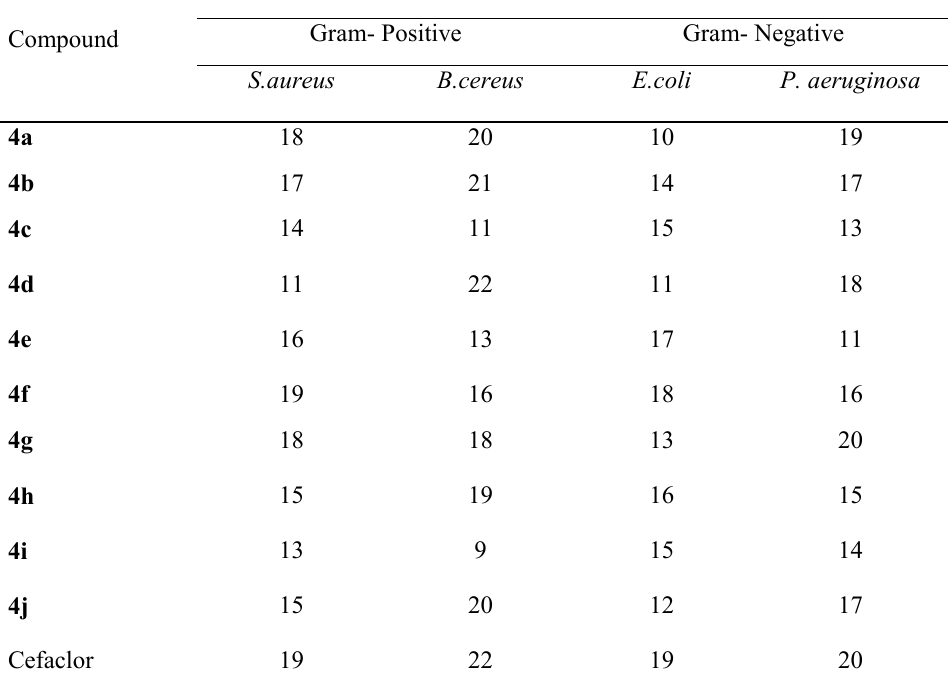
Table 3 . Antibacterial activity of 4a-j